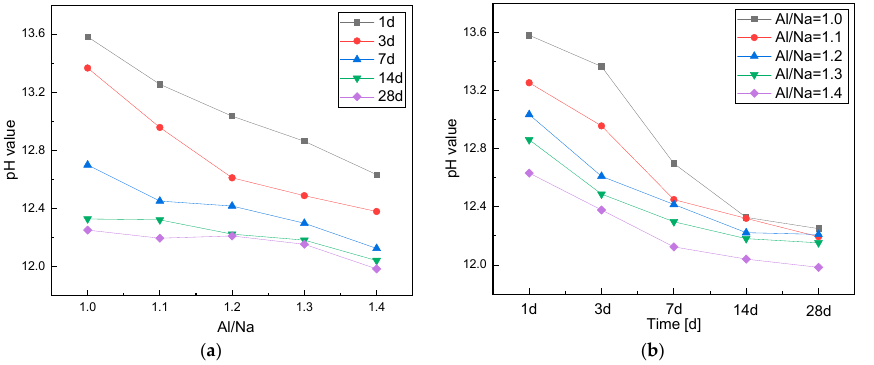
Figure 2. ( a ) A chart of the changes in the pH of the pore solutions with Al/Na ratio; ( b ) a chart of the changes in the pH of the pore solutions with